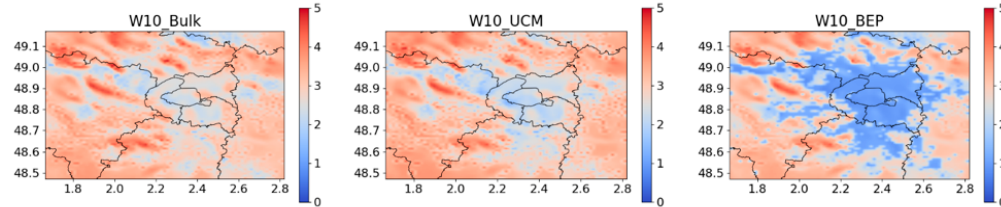
Figure 8. Maps of the mean 10 m wind speed (m s − 1 ) over the period from 27th November to 4th